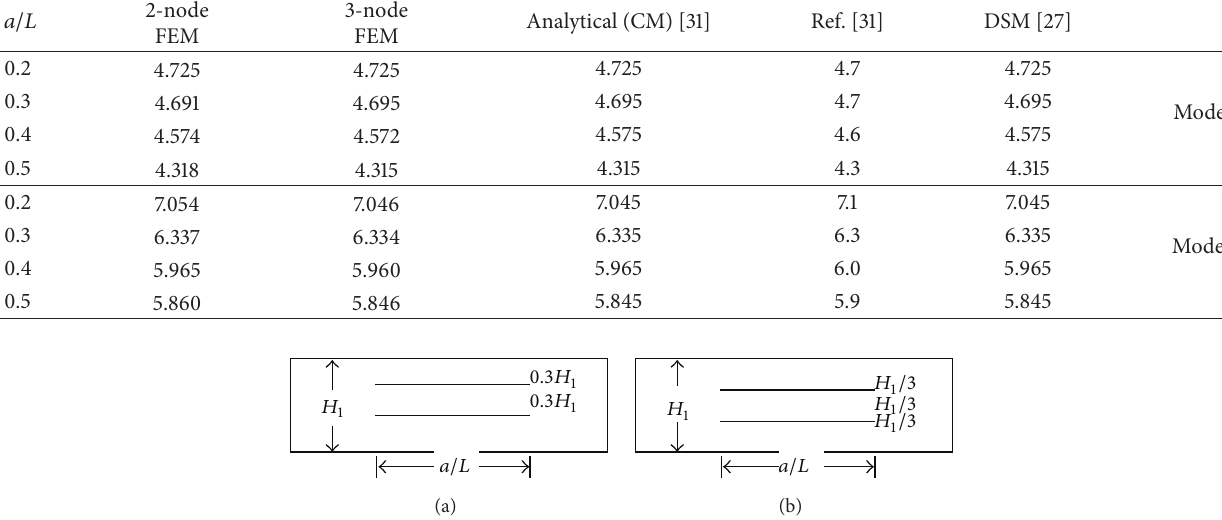
Figure 8: The first (a) and second (b) double-delamination models tested.